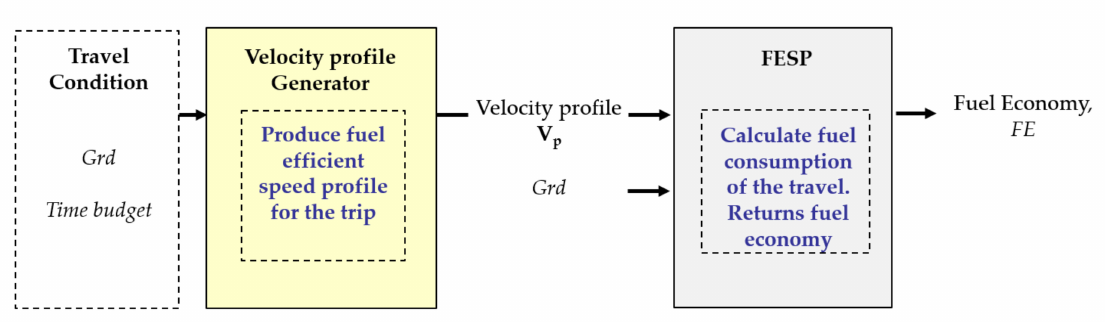
Figure 1. Input / output diagram of the proposed method. The velocity profile generator takes road grade information and time budget as input and returns the velocity profile as output. The FESP calculates fuel economy at the end of the trip. Our goal is to generate velocity profiles that maximize